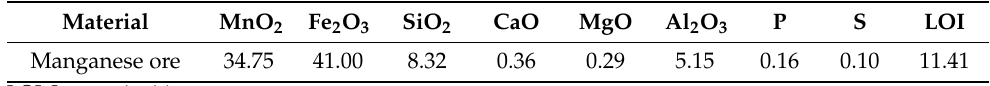
Table 1. Main chemical composition of the manganese ore, wt%.